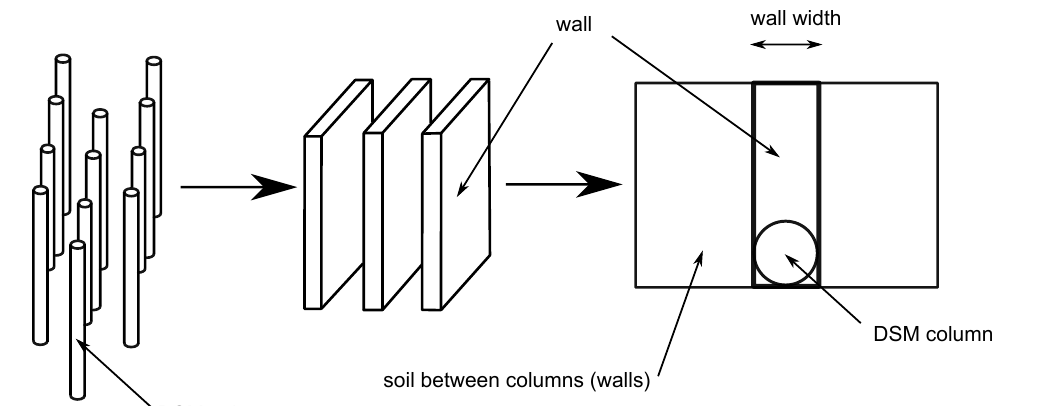
Figure 2. The principle of replacing DSM pillars in a plain strain model by a virtual wall. Adapted from [4].